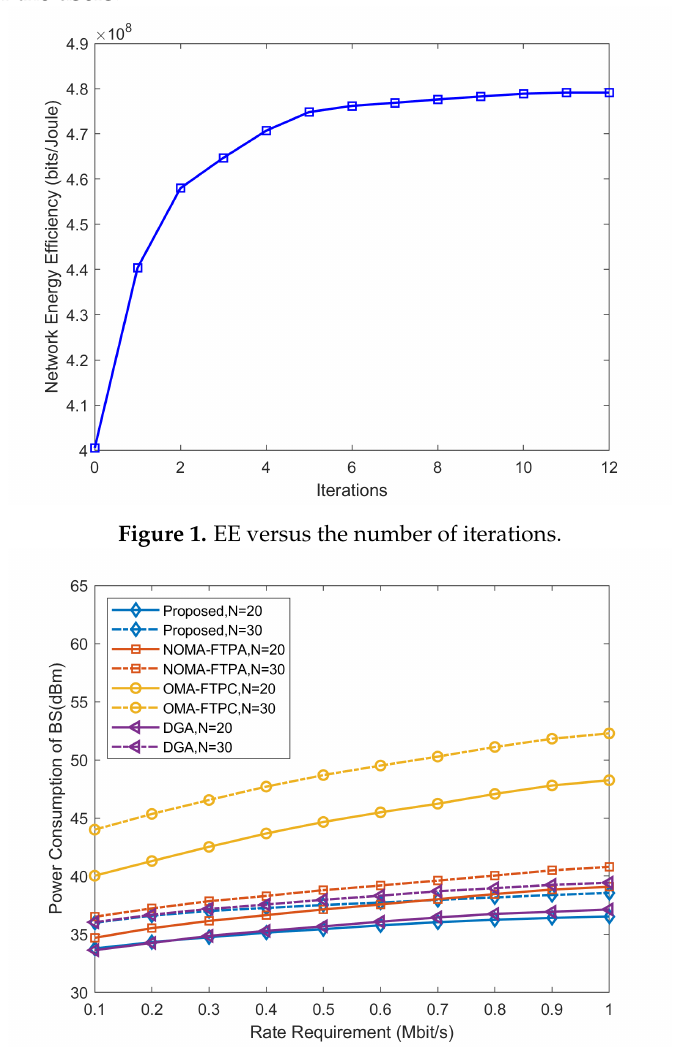
Figure 2. Power consumption for different rate